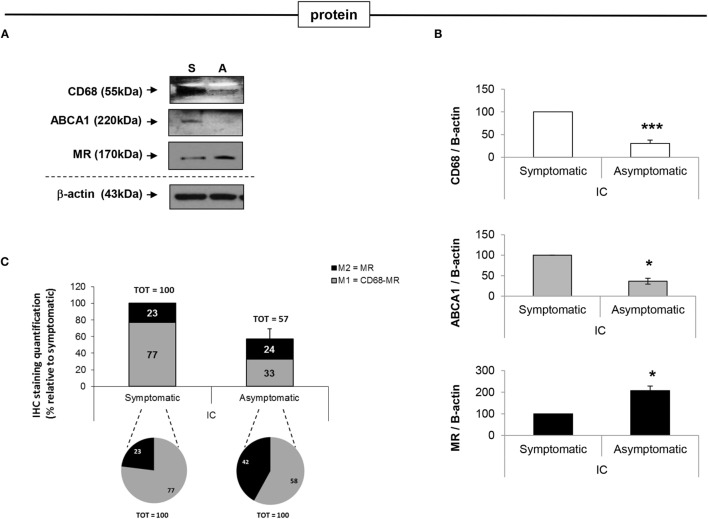
Analysis of protein expression of MΦ1 and MΦ2 markers in symptomatic vs. asymptomatic patients. (A) Western Blot and (B) the relative densitometry analysis, confirm RT-PCR analysis of selected macrophage markers, where ABCA1 is increased and MR is decreased in symptomatic (S) compared with asymptomatic (A) plaques, suggesting a switch from MΦ2 to MΦ1 macrophage thus enriching the pro-inflammatory fraction population, as disease progresses. (C) Protein expression was also quantified by IHC analysis to determine the relative distribution of MΦ1 and MΦ2 macrophage populations, within asymptomatic and symptomatic plaques. Quantification of CD68 and MR staining is shown. In symptomatic plaques, MΦ1 macrophages are increased relative to MΦ2. In addition, the absolute number of MΦ1 macrophages is increased in symptomatic compared to asymptomatic plaques. As expected, the percentage of MΦ2 macrophage, relative to MΦ1 cells, is significantly greater in asymptomatic compared to symptomatic patients (pie charts), even though their absolute number between symptomatic and symptomatic lesions is similar (bars). For all the experiments above mentioned, data are mean ± SEM where *p < 0.05, **p < 0.01, ***p < 0.001 vs. symptomatic after T-test analysis of N = 3 independent experiments.